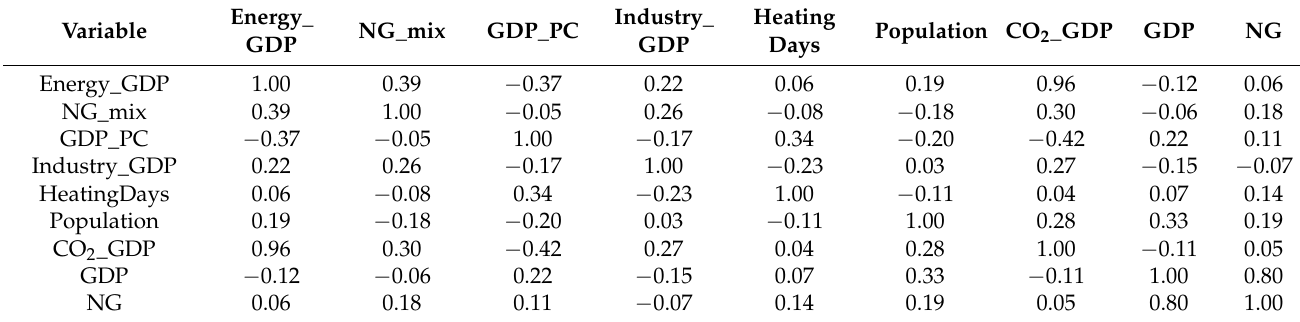
Table 3. Correlation coefficients for all